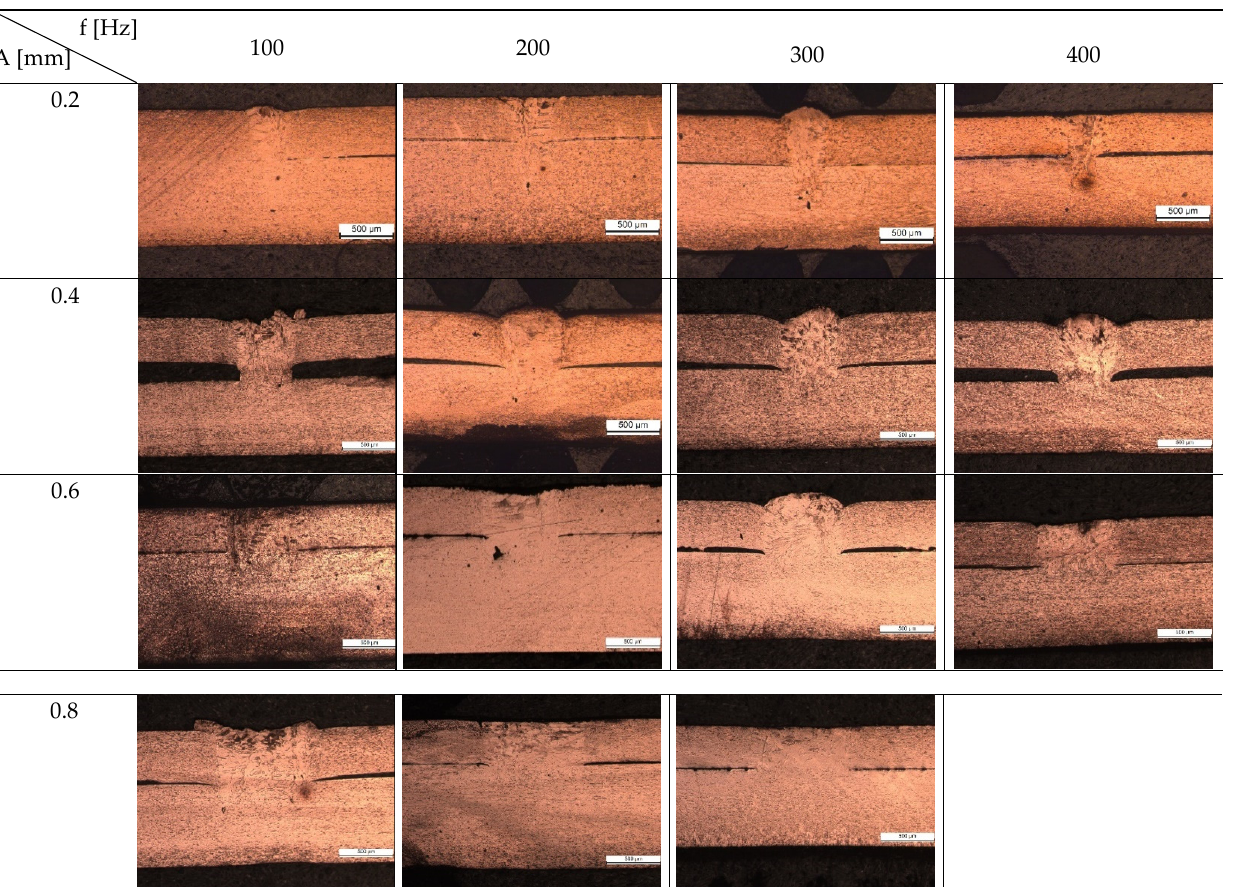
Figure 10. ( a ) Weld depth and ( b ) weld width versus oscillating amplitudes (0.2 mm, 0.4 mm, 0.6 mm, and 0.8 mm) and oscillation frequencies (100 Hz, 200 Hz, 300 Hz, and 400 Hz). 3.3. Weld Microstructure Figure 11 shows the optical micrograph of the sample produced with an oscillation amplitude of 0.2 mm and an oscillation frequency of 100 Hz. Three distinct microstruc- tural zones can be defined from this figure; the fusion zone (FZ), the adjacent heat-affected zone (HAZ), and the base metal (BM). The BM is the region in which the heat was not sufficient to create any microstructural changes. The initial microstructure in this region, which consisted of the fine equiaxed grains, remained unaffected. In the HAZ, the heat input was not enough to melt the copper but caused recrystallisation and grain growth due to overheating, creating an overgrown equiaxial microstructure. In the FZ, the region where the material was melted, mostly coarse columnar grains can be observed. Pure cop- per does not undergo a solid-state transformation, and it can be seen from Figure 11 that the main difference in BM and HZ microstructure was the difference in the size of the grains. However, the structure of grains in the FZ was also altered.